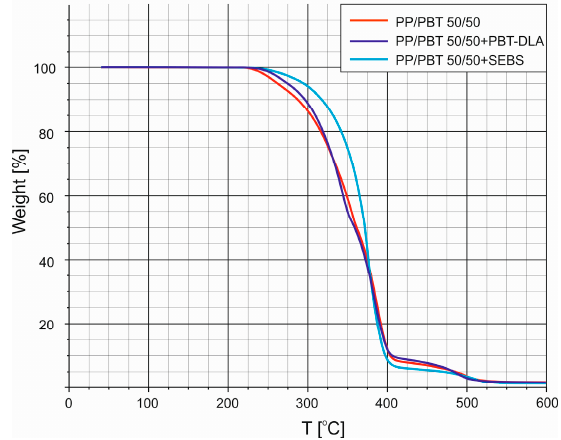
Figure 6. Non-isothermal analysis of TG thermograms of 50/50 PP/PBT blends with triblock (SEBS) and random (PBT–DLA) compatibilizers.